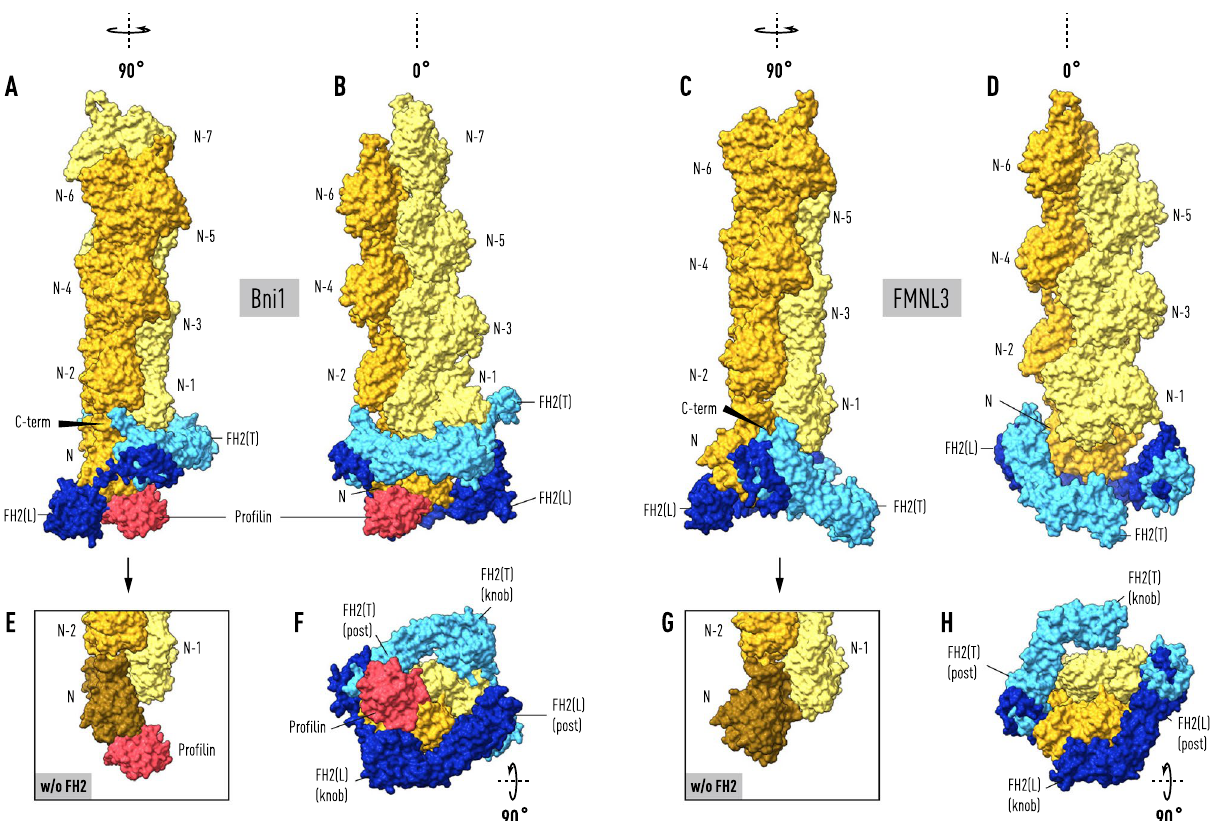
Figure 1. Actin filaments docked onto formin:actin heterodimers support a ‘stepping second’ model. The two panels on the left depict the result of superimposing the terminal subunit of a 6-mer (in lemon and orange) of the helical actin filament (PDB code: 6DJO) onto actin molecule (N−1) bound to the trailing FH2(T) domain (light blue) in the Bni1:actin heterodimer (PDB code: I64Y). With this alignment, actin(N) bound to FH2(L) (in dark blue) does not fit the helical symmetry of the filament but is instead coplanar with actin(N−2). Actin subunits in the filament are not N-acetylated. Superposing β-actin from the crystal structure of profilin-β- actin (PDB code: 2BTF) onto actin(N) places profilin (in red) in a shallow surface pocket where it forms significant salt-bridges with FH2(L) and the N-terminus of actin(N). The coplanarity of actin(N) (in brown) with actin(N−2) is seen in the bottom panels ( E , G ) where FH2 has been removed. The two panels on the upper right show the terminal subunit of a 6-mer of the helical actin filament docked onto actin(N) of the mammalian formin FMNL3:actin crystal structure (PDP code: 4EAH). For consistency in relating the Bni1 and FMNL3 filament-bound structures to a second stepping model, the FH2 domains are labeled so that actin(N) is bound to FH2(L) on the right even though it is not the ‘leading’ FH2 domain. Not shown in the panels on the right is the actin molecule bound to FH2(T) in the crystal structure which is in a ‘jammed’ position evidently caused by front-to-back packing between the two ‘biological units’ in the asymmetric unit (see “Methods”). Alignment of the filament axes in the Bni1 (left panels) and FMNL3 models (right panels), discloses a two-state ‘stepping second’ model in which FH2(T) descends towards the barbed end to create an open pocket for the binding of actin(N+1) with the dissociation of profilin from actin(N). The arrows (panels A and C ) point to the prominent α-helix at the C-terminus (C-term) of FH2(T) at the interface between actin(N−2) and